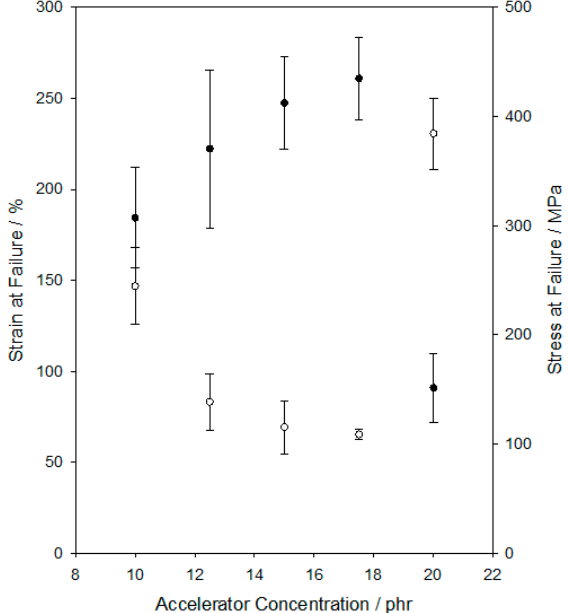
Figure 1. Plots showing the effect of accelerator concentration on strain at failure (  ) and stress at failure (  ). failure ( •